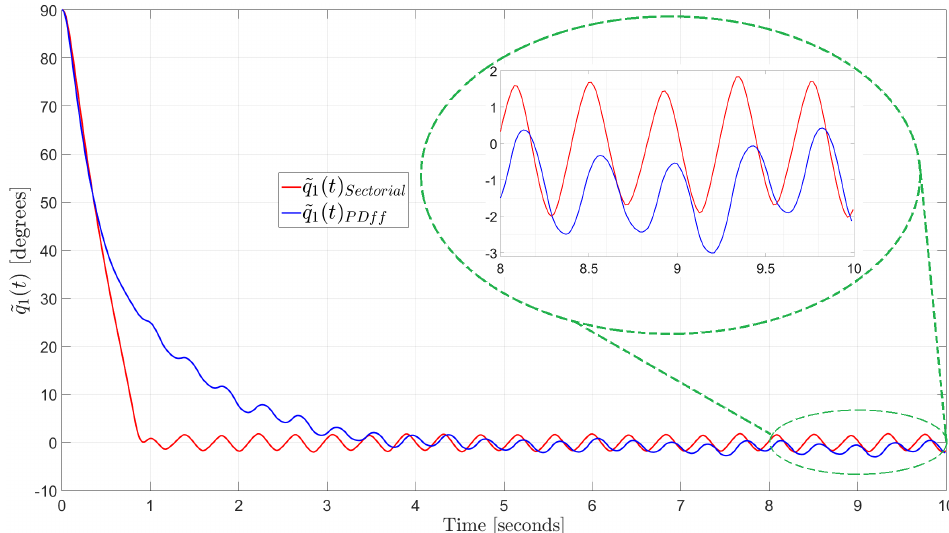
Figure 25. Angular position error for joint 1.